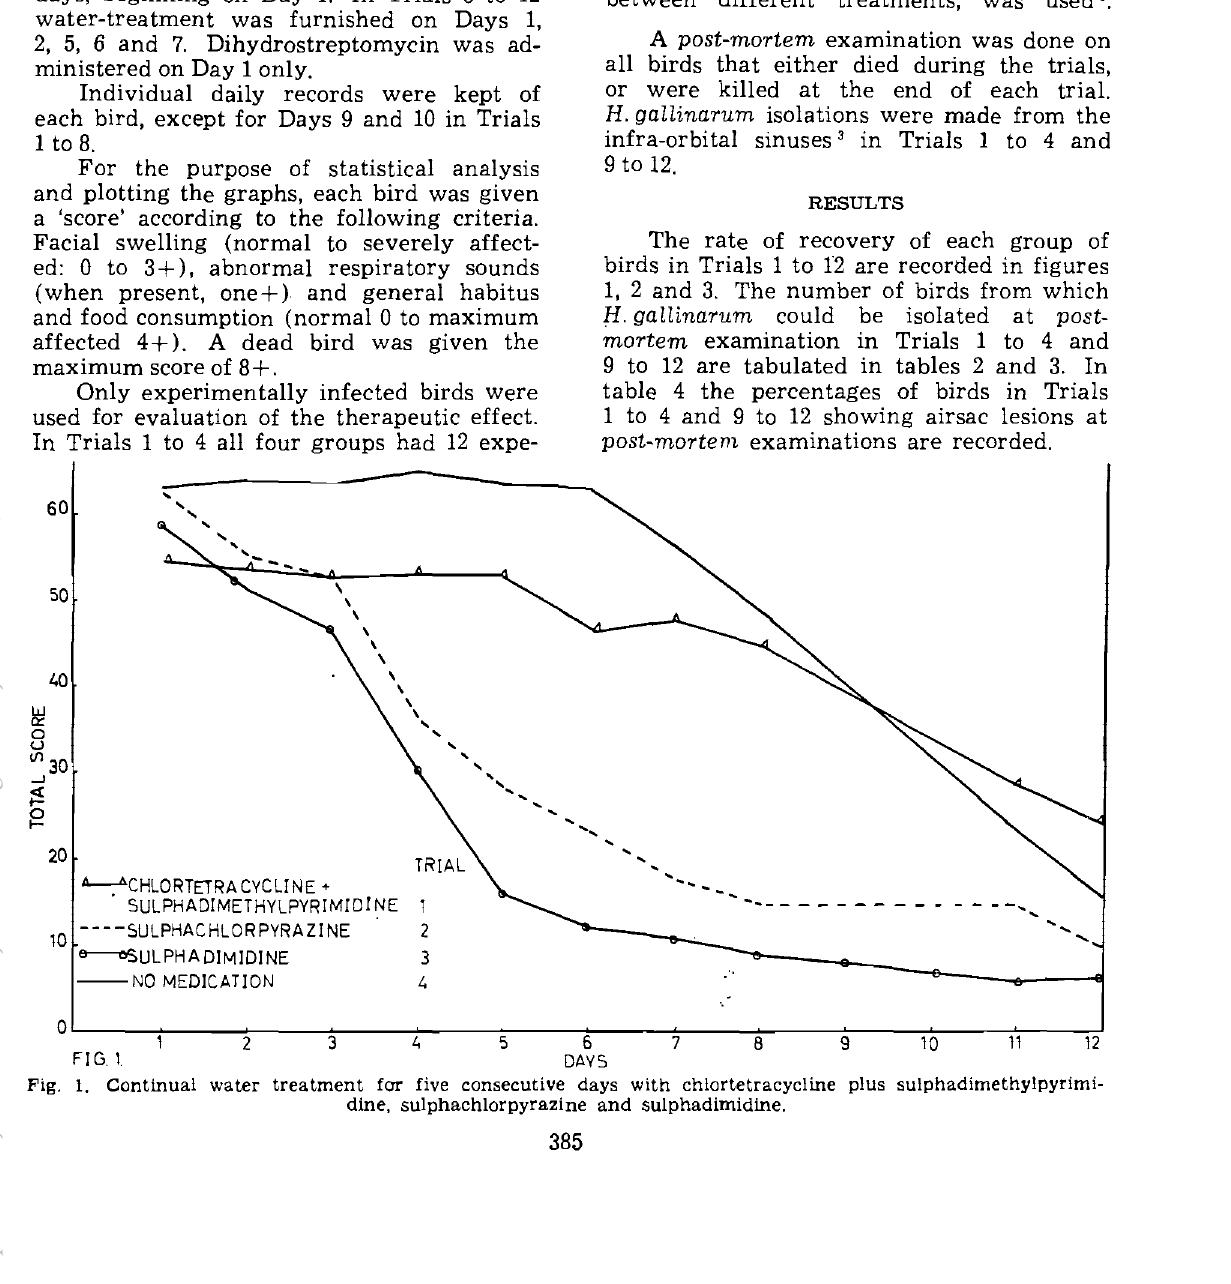
table 4 the percentages of birds in Trials 1 to 4 and 9 to 12 showing air sac lesions at post-mortem examinations are